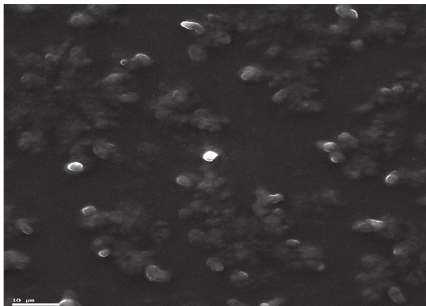
Figure 3: Scanning electron microscopy image of levofloxacin niosomes ( × 1310).